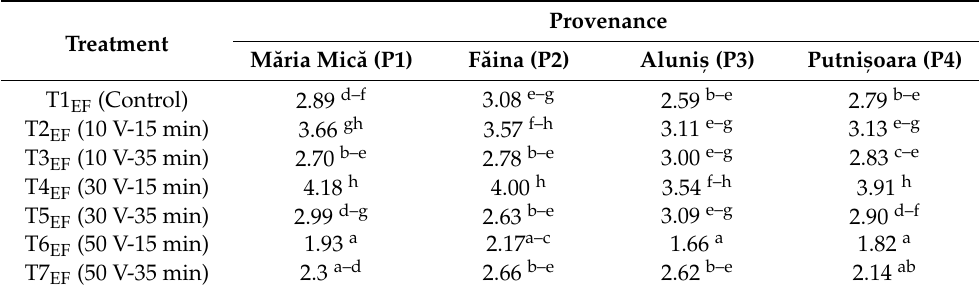
Table 2. Seedlings’ height (cm) depending on the interaction between treatment and provenance after seeds were exposed to EF treatments.